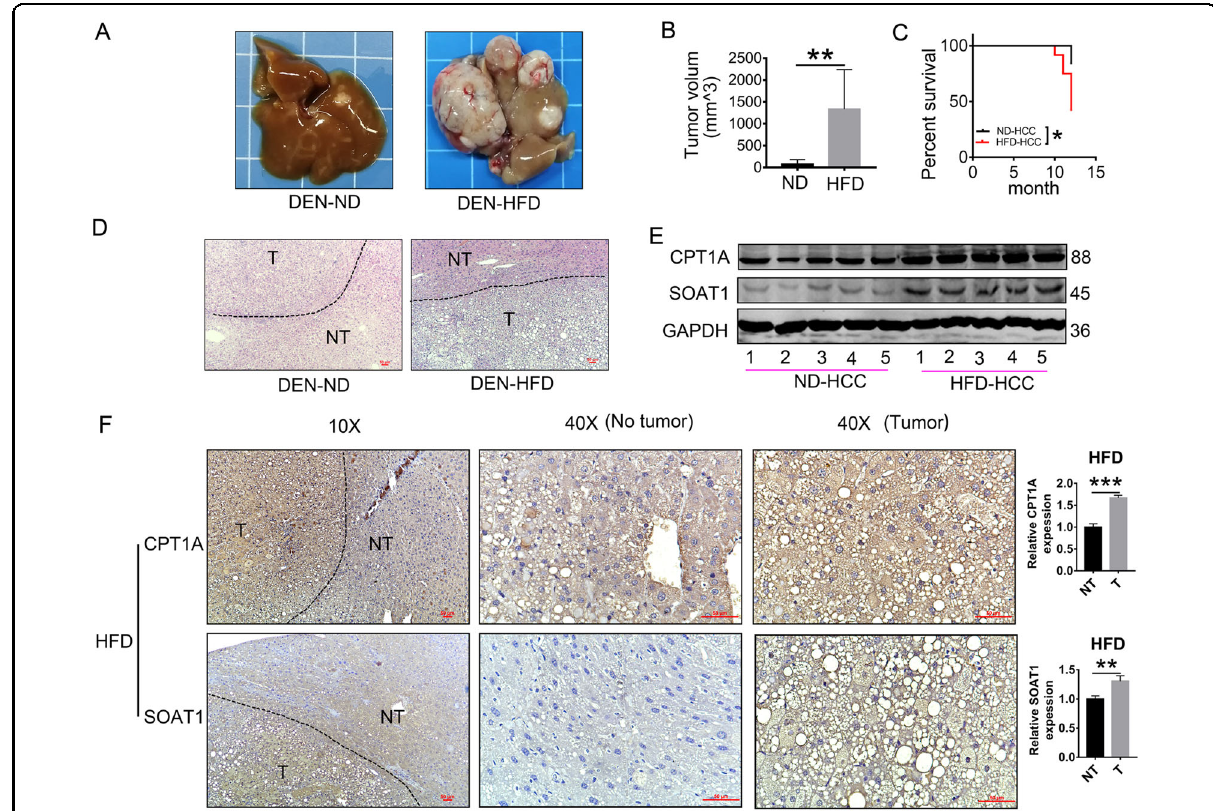
Fig. 1 HFD improves the expression of SOAT1 and CPT1A in DEN - induced HCC. A – B A high-fat diet exacerbated HCC progression in DEN- injected mice. Representative images of the livers ( A ) and tumor volumes ( B ), ND: the normal diet group ( n = 8) and HFD: the high-fat diet group ( n = 5). (mean± SEM) ** p < 0.01. C Kaplan – Meier survival plot of DEN-injected mice on a high-fat diet (HFD) or normal diet (ND); * p < 0.05. D H&E- stained images of livers using HCC and adjacent non-tumor liver tissue in ND-fed or HFD-fed mice (scale bar, 50 μ m). NT and T indicated non-tumor and tumor areas, respectively. E Western blot analysis of SOAT1 and CPT1A in liver cancer tissues from ND-fed or HFD-fed mice. F Representative IHC staining ( n = 5 images in total) of SOAT1 or CPT1A in the tissues obtained from HFD-fed mice. NT and T indicate non-tumor and tumor areas, respectively (scale bar, 50 μ m). Five separate areas from each tissue were quanti fi ed (mean± SEM); * p < 0.05; ** p < 0.01, *** p <